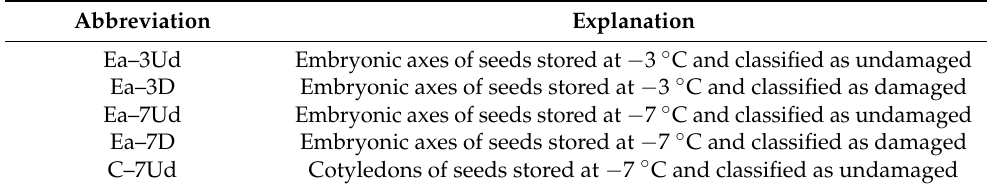
Table 1. Explanations of abbreviated treatments with statistically confirmed differentially up- or downregulated